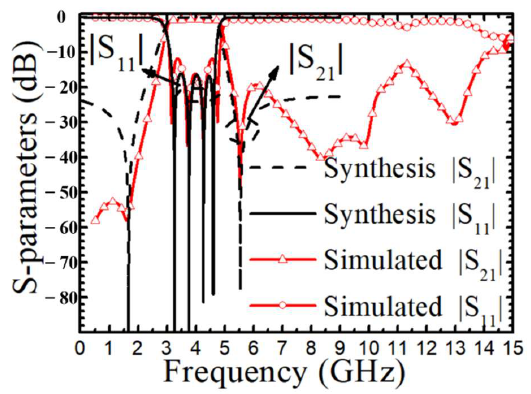
Figure 11. Synthesized and simulated S-parameters.